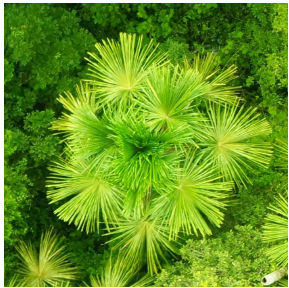
Figure 1. Aerial view of a Mauritia flexuosa